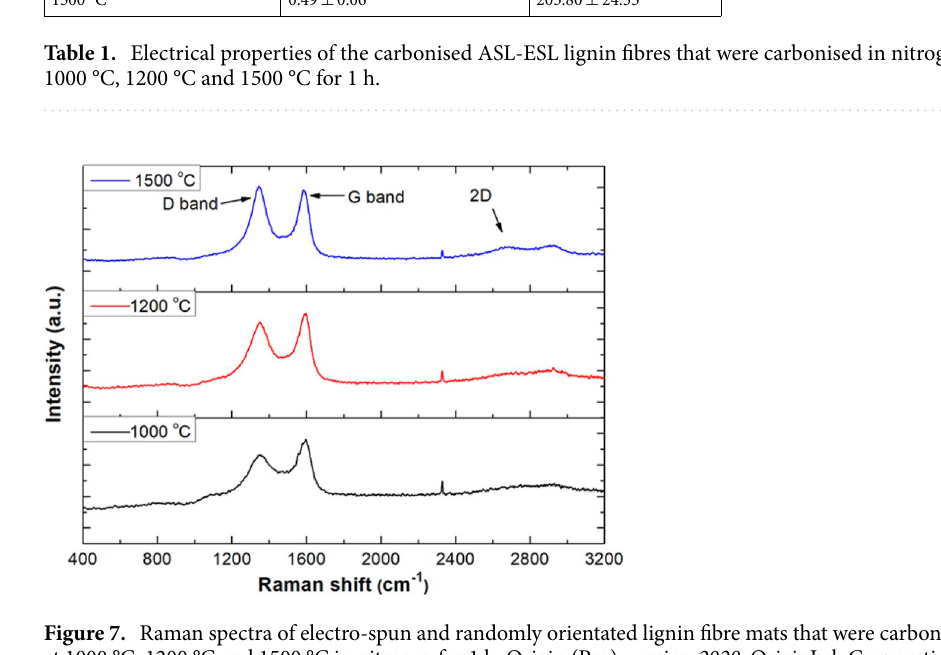
Figure 7. Raman spectra of electro-spun and randomly orientated lignin fibre mats that were carbonised at 1000 °C, 1200 °C and 1500 °C in nitrogen for 1 h. Origin (Pro), version 2020 . OriginLab Corporation, Northampton, MA, USA. https:// www. origi nlab.